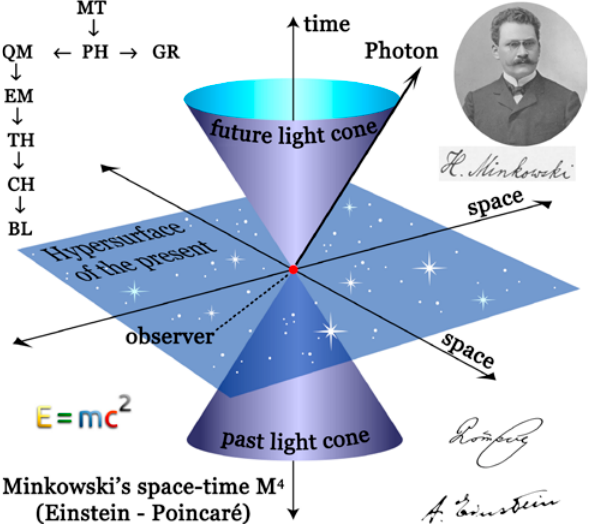
Figure 1. A picturing of the current materialistic paradigm in West- ern science. Reality is manifested in a 4D-continuum (x,y,z,ic·t) called Minkowski’s space, having inaccessible zones out of a light cone associated to a given observer. On the left, a schematic hier- archy for scientific disciplines shown here as the progression: math- ematics (MT) → physics (PH) → quantum mechanics (QM) → elec- tromagnetism (EM) → thermodynamics (TH) → chemistry (CH) → biology (BL). General relativity (GR, not illustrated here) is repre- sented as a separate branch owing to the considerable difficulties met for merging this science with quantum